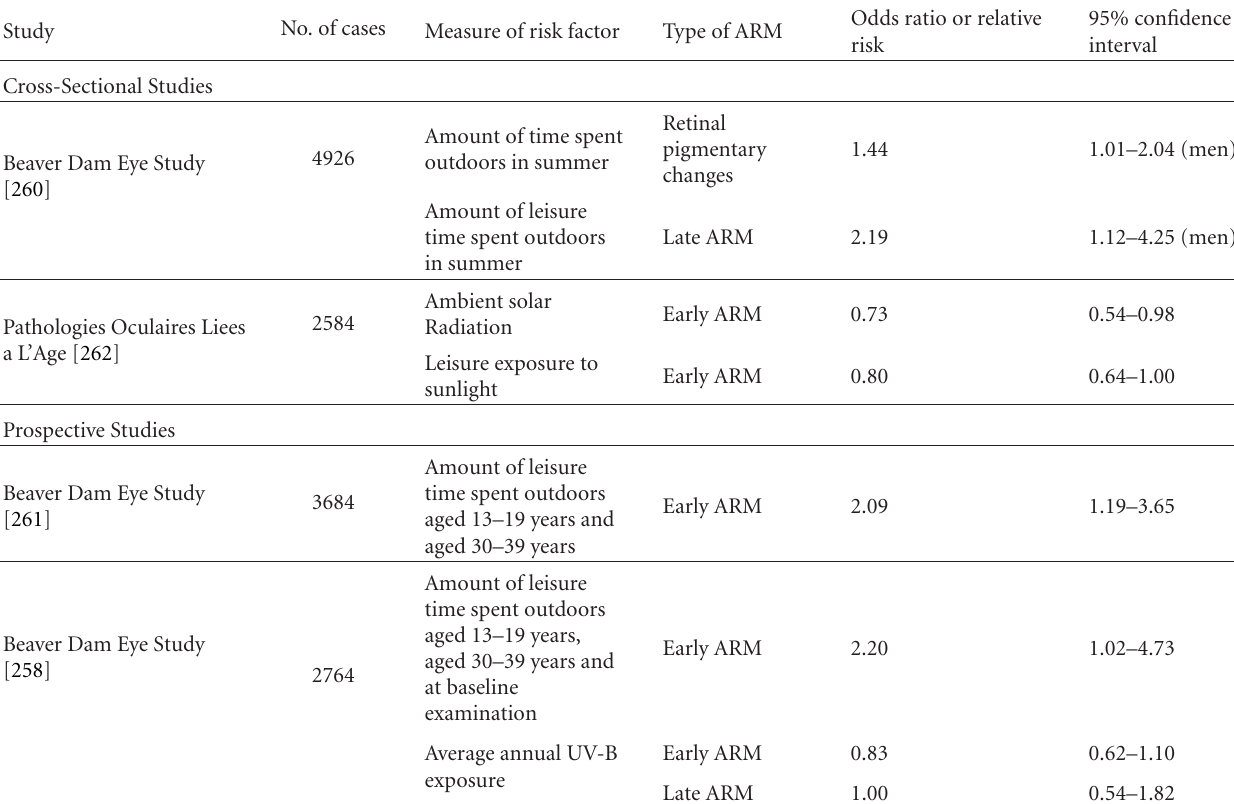
Table 15: Studies investigating the relationship between cumulative sunlight exposure and risk for